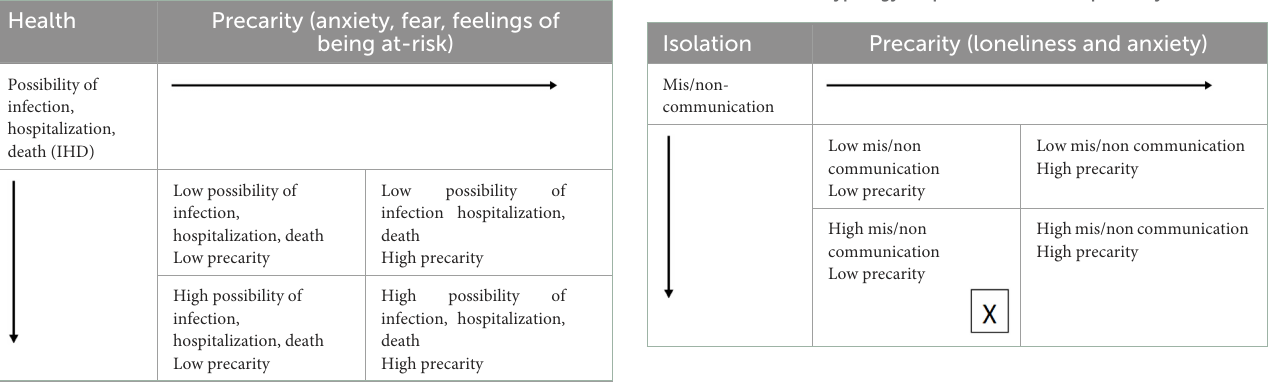
TABLE 7 Evolution of typology, step 2d–Isolation and precarity.